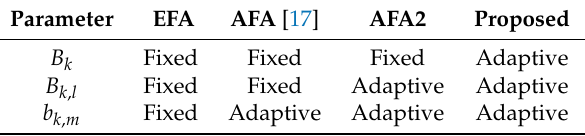
Table 1. Comparison of the feedback bits allocation